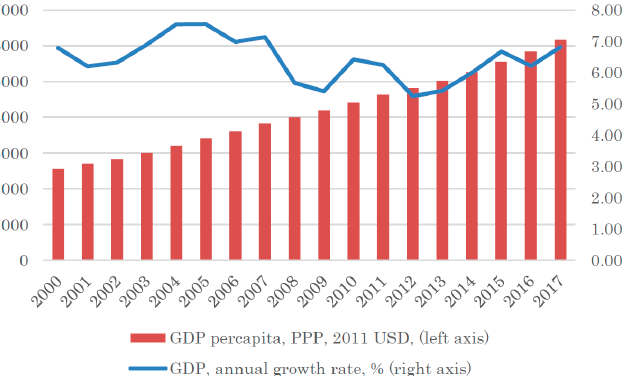
Figure 1. GDP growth rate and GDP per capita (Data from: https://lienvietpostbank.com.vn/ [3] (accessed on 26 June 2020)).